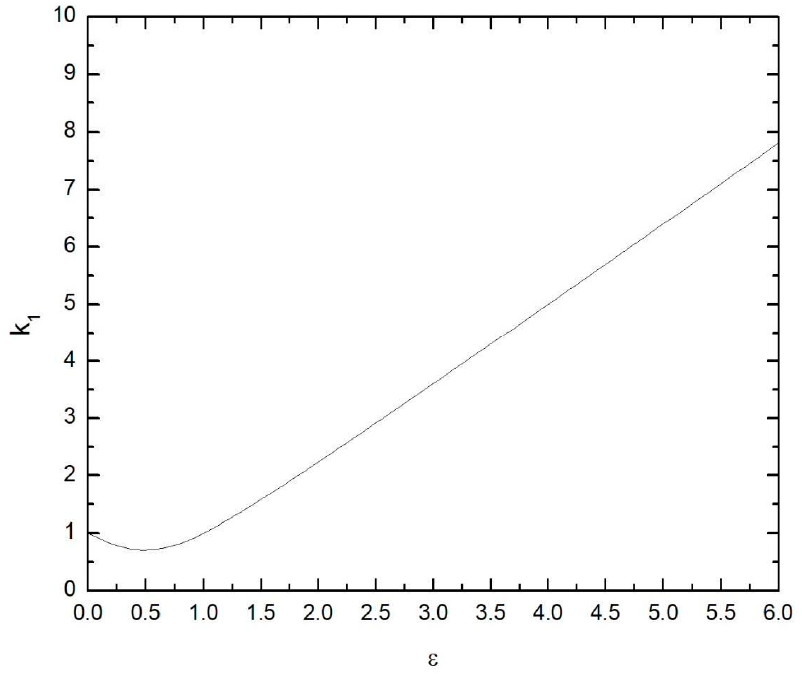
Figure A1. The dependence of the error enhancement coefficient on the parameter ε .